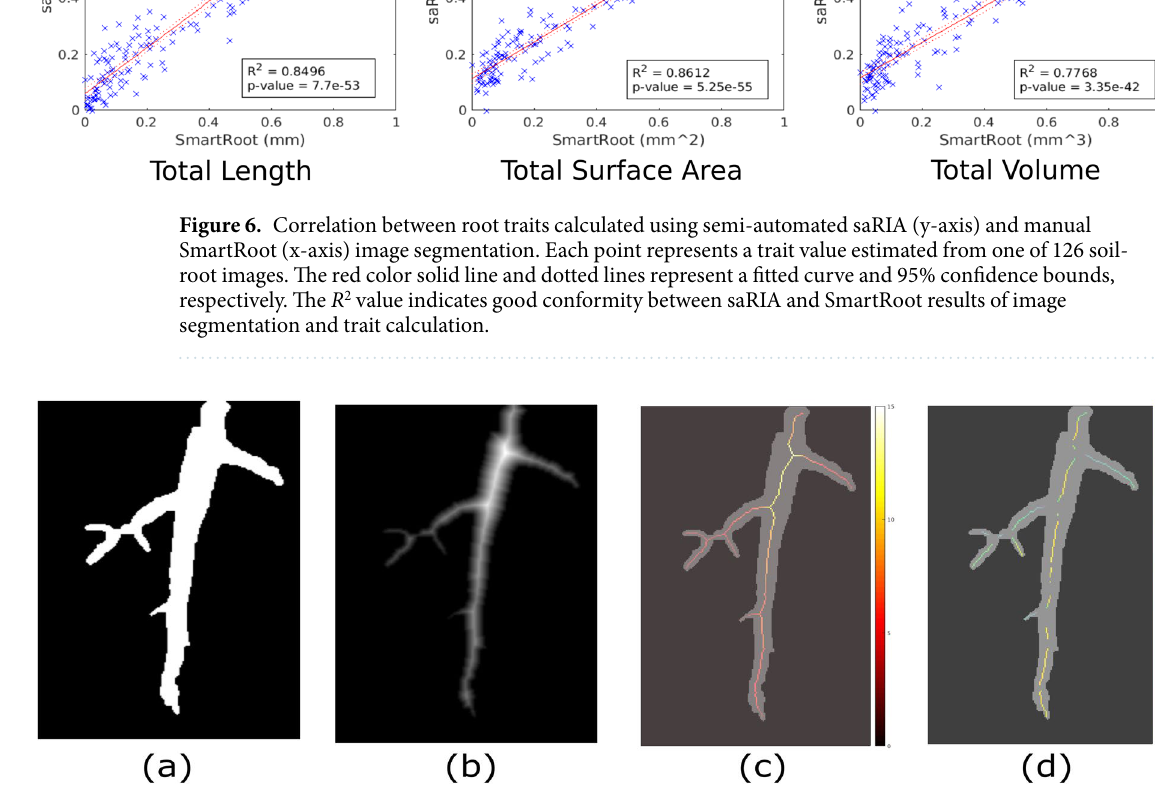
high-intensity central pixels represent the root width. The corresponding width color map is shown in Fig. 7c. The width feature is useful to calculate the root volume and surface area for biomass estimation. Figure 7d displays the absolute orientation of each root skeleton pixel with respect to the horizontal axis in black-yellow color-map representation. Here, a validated linear regression model was used to calculate the slope of a pixel in the skeleton image. The local slope in i -th pixel is obtained by fitting a tangent line to the fraction of root skeleton framed by a 15 × 15 pixel mask around the i -th pixel. An exemplary figure for the local linear fit can be found in Supplementary Information (Fig. S1). The validated regression model means that only pixels satisfy- ing the regression model with a high confidence level (i.e. p-value < 0.05 and R 2 > 0.5) were accepted. Pixels with